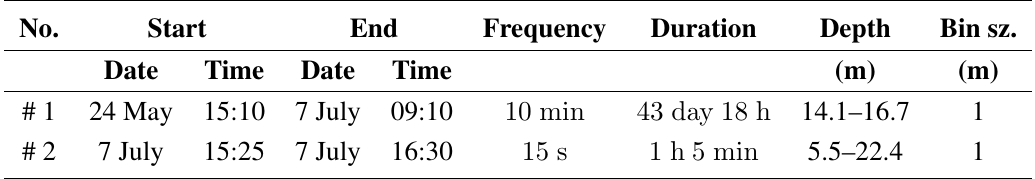
No. Start End Frequency Duration Depth Bin